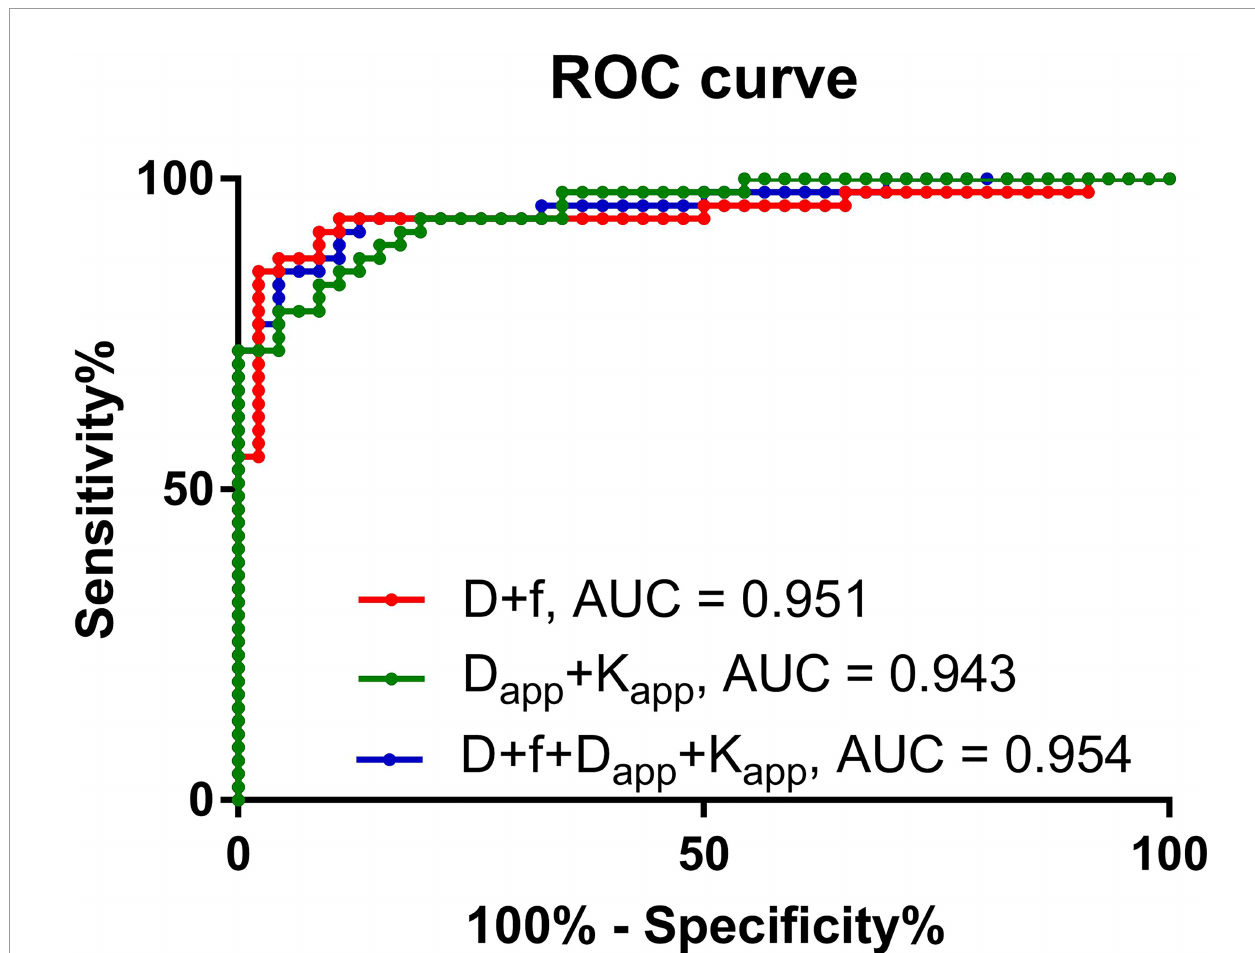
FIGURE 4 | Receiver operating characteristic curve of the predictive performance of different prediction models.